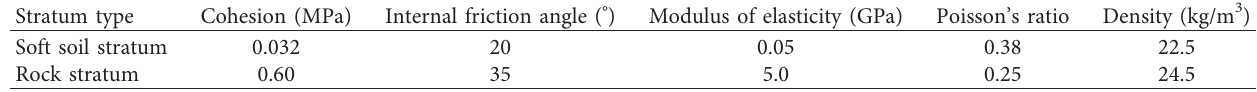
and Figure 7: (1) FOS of foundation pit vertical soil sidewall decreases with the increase of soil wall excavation height.